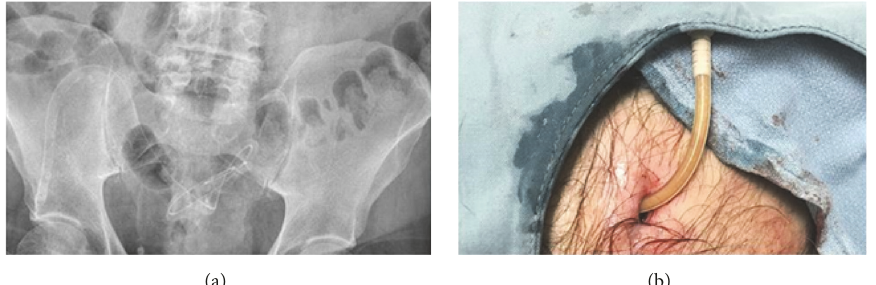
Figure 1: (a) Plain radiograph of the abdomen showing position of catheter prior to exteriorization. (b) Catheter immediately after